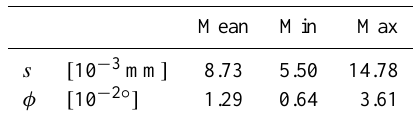
Figure 7. Convex hull of the positions of the MP center for a set of configurations of the wrist inside the operative workspace. Table 1. Statistical values of the displacement error s and orienting error φ inside the operative workspace.